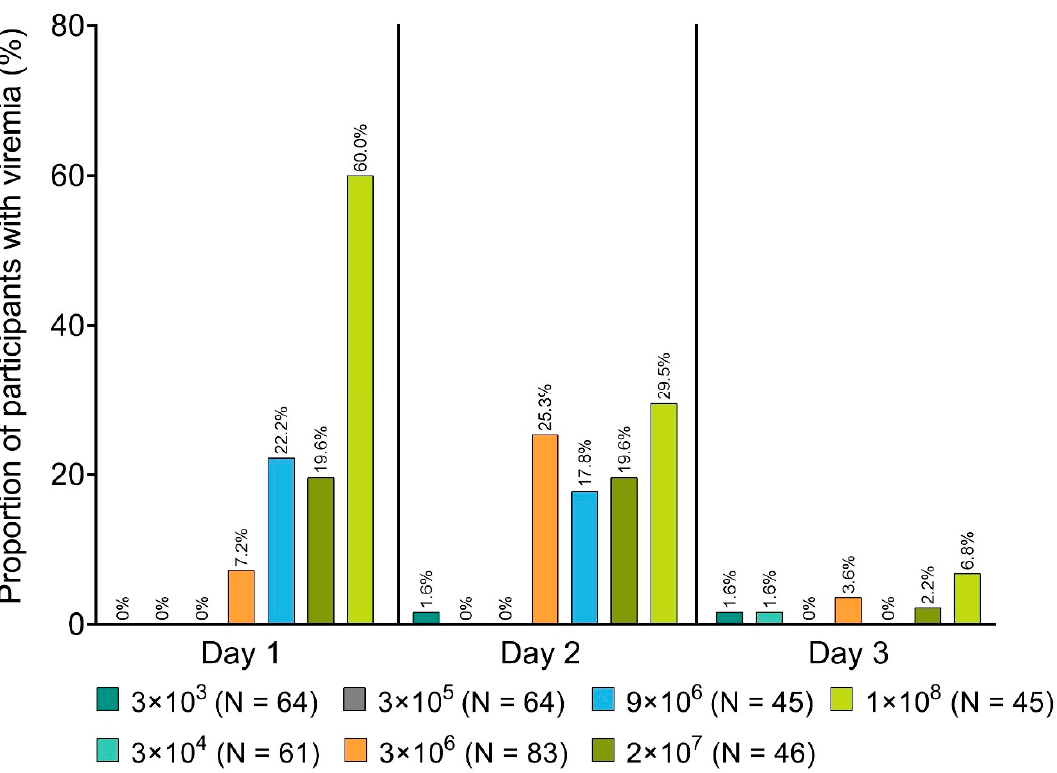
Figure 5. rVSV Δ G-ZEBOV-GP viremia rates, over the first 3 days post-inoculation, among participants in the V920-004 phase 1 clinical trial.